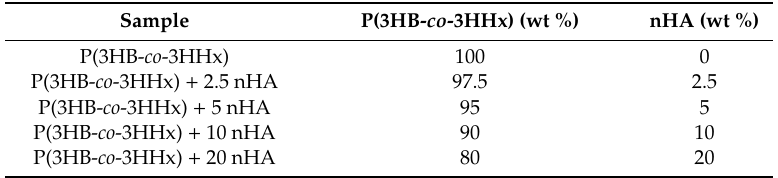
Code and composition of the samples prepared according to the weight content (wt %) of poly(3-hydroxybutyrate- co -3-hydroxyhexanoate) [P(3HB- co -3HHx)] and hydroxyapatite nanoparticles